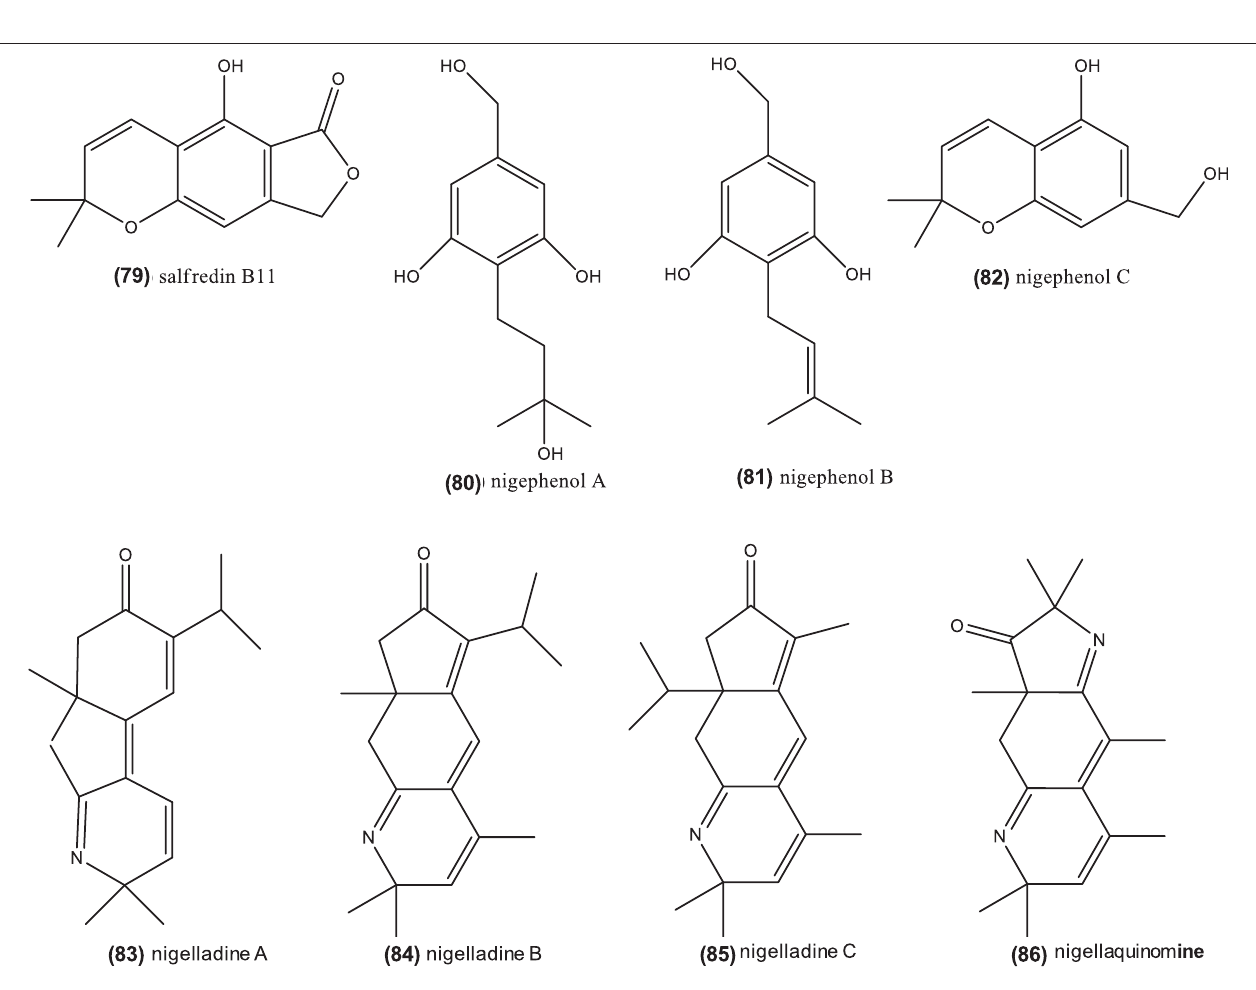
Frontiers in Pharmacology |